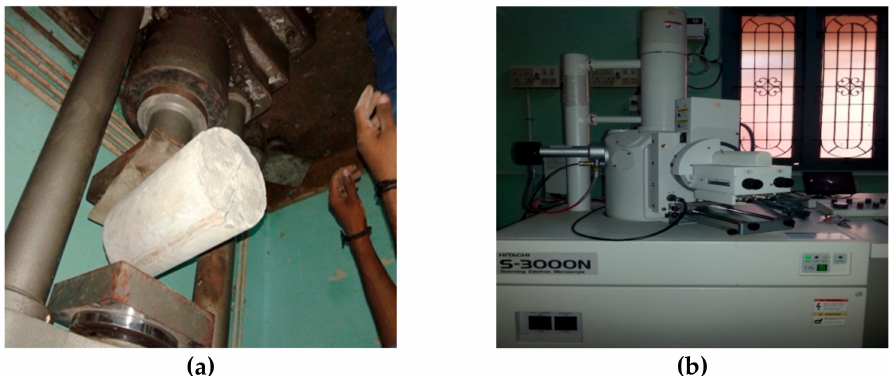
Figure 4. ( a ) Compression testing machine and ( b ) scanning electron